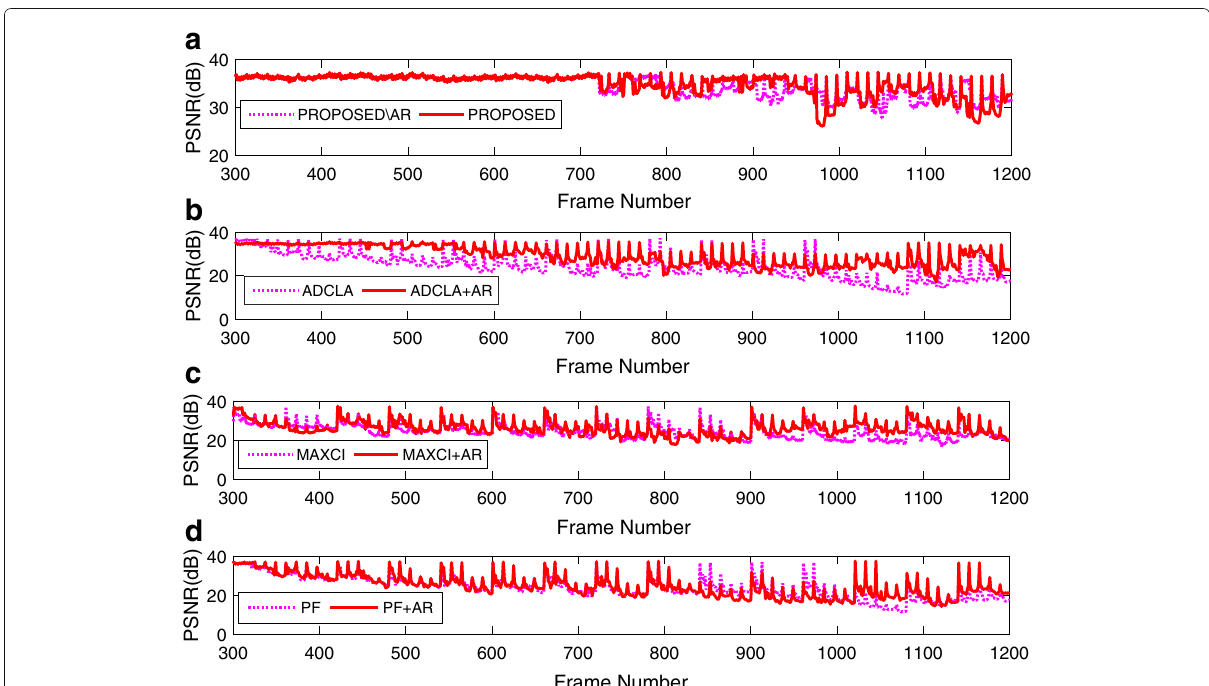
Fig. 8 The comparison of the average PSNR of all the clients for each frame for different packet scheduling and resource management algorithms by employing our proposed segment request scheme AR or not. a Average PSNR of all the clients for each frame for PROPOSED vs. PROPOSED-AR. b Average PSNR of all the clients for each frame for ADCLA+AR vs. ADCLA. c Average PSNR of all the clients for each frame for MAXCI+AR vs. MAXCI. d Average PSNR of all the clients for each frame for PF+AR vs.